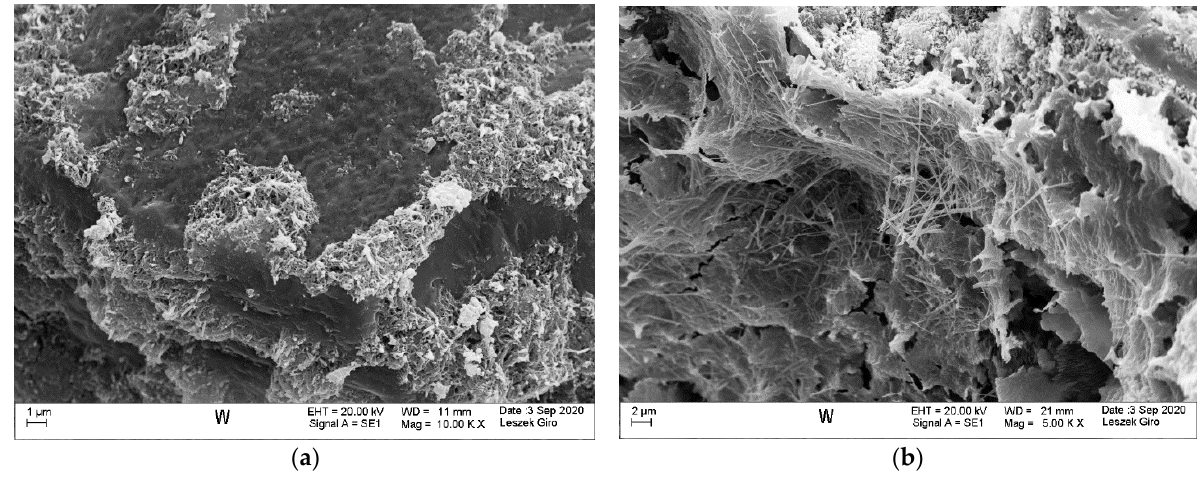
Figure 7. Microstructure of the specimen stored in tap water; visible compact C-S-H phase ( a ) and fibrous C-A-S-H phase formations ( b ).